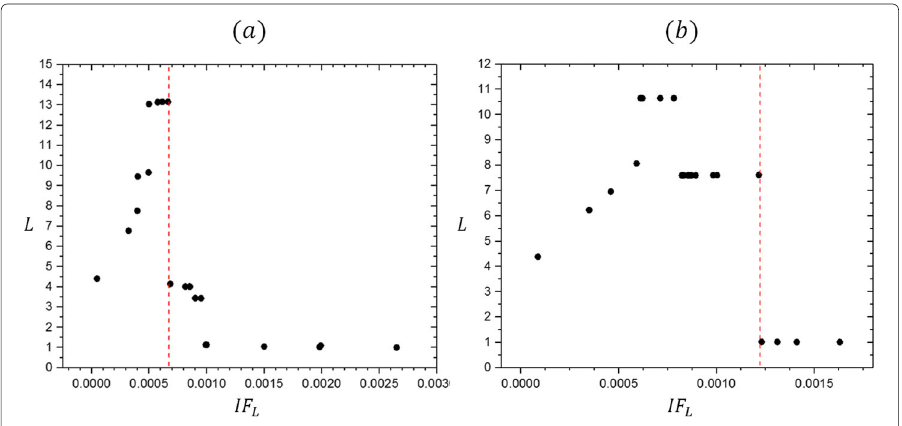
Fig. 1 Behavior of the average minimum path taking into account the IF L for TVSNT of Nature for w 8,1 in ( a ) t = 7 and ( b ) t = 223